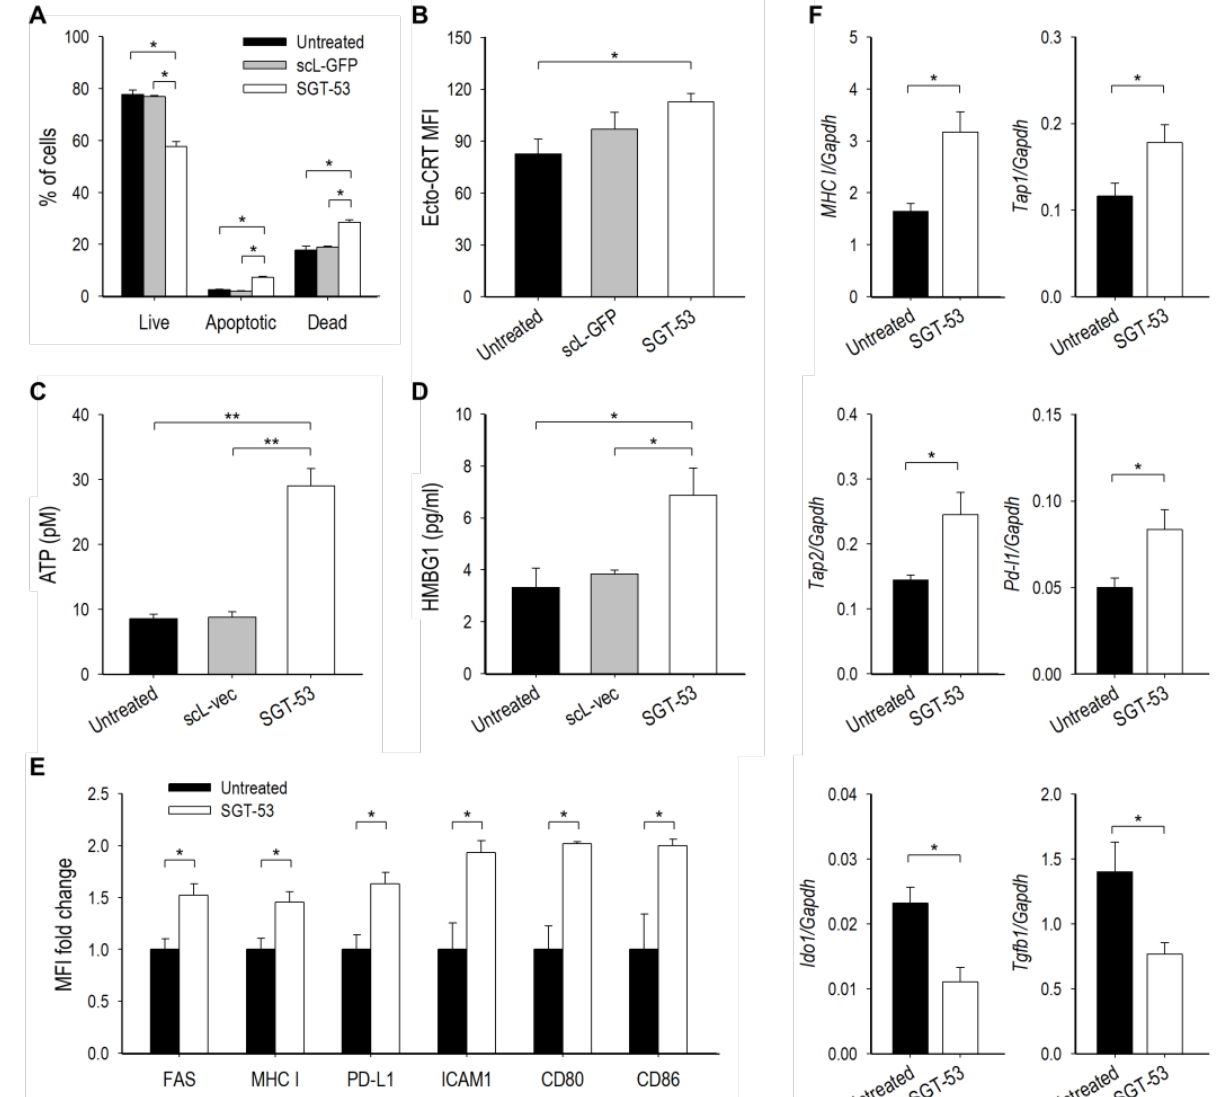
Figure 5. SGT-53 increases immunogenicity of tumor cells both in vitro and in vivo. For in vitro study, LL/2 cells were transfected with SGT-53 or a tumor-targeting nanocomplex loaded with ei- ther a plasmid encoding GFP (scL-GFP) or an empty plasmid vector (scL-vec). ( A ) Induction of apoptosis was assessed via Annexin V/7-AAD staining. n = 5/group. ( B ) Surface expression of ecto- CRT was assessed via flow cytometry. The mean fluorescence intensity (MFI) was plotted. n =